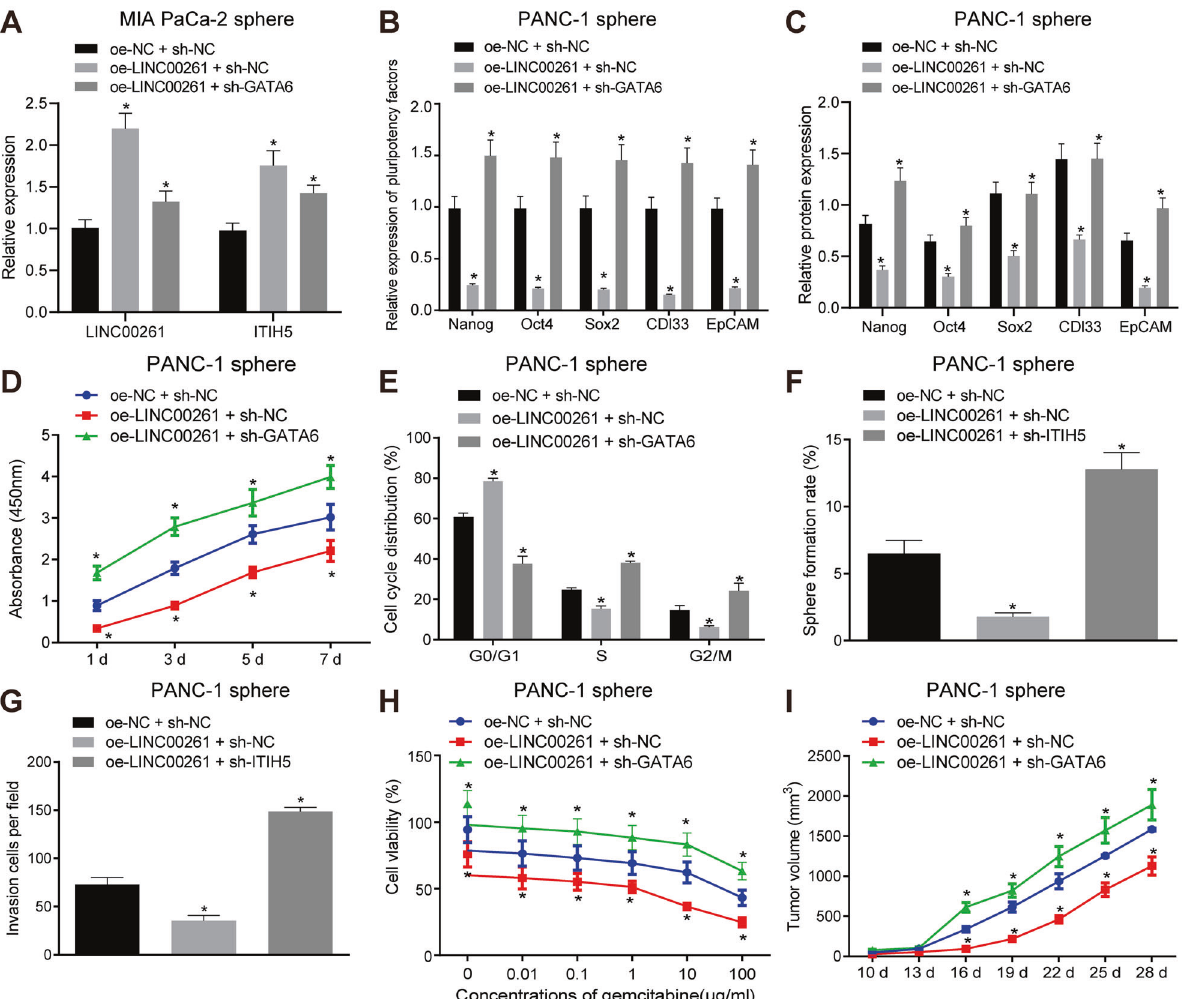
Fig. 6 Upregulation of LINC00261 reduces the tumorigenicity of PC stem cells by recruiting GATA6. A Expression of LINC00261 and ITIH5 determined by RT-qPCR. B mRNA expression of stem cell markers in PANC-1 stem cells determined by RT-qPCR. C Protein expression of stem cell markers in PANC-1 stem cells analyzed by western blot analysis. D Proliferation of PANC-1 stem cell examined by CCK-8 assay. E Cell cycle distribution of PANC-1 stem cells examined by fl ow cytometry. F Cell sphere formation ability of PANC-1 stem cells. G Invasion of PANC-1 stem cells assessed by Transwell assay. H Cytotoxicity of PANC-1 cells. I Tumor volume in nude mice bearing PANC-1 stem cells, n = 5. * p < 0.05 vs. the oe-NC + sh-NC group. Each experiment was repeated three times and measurement data were expressed as mean ± standard